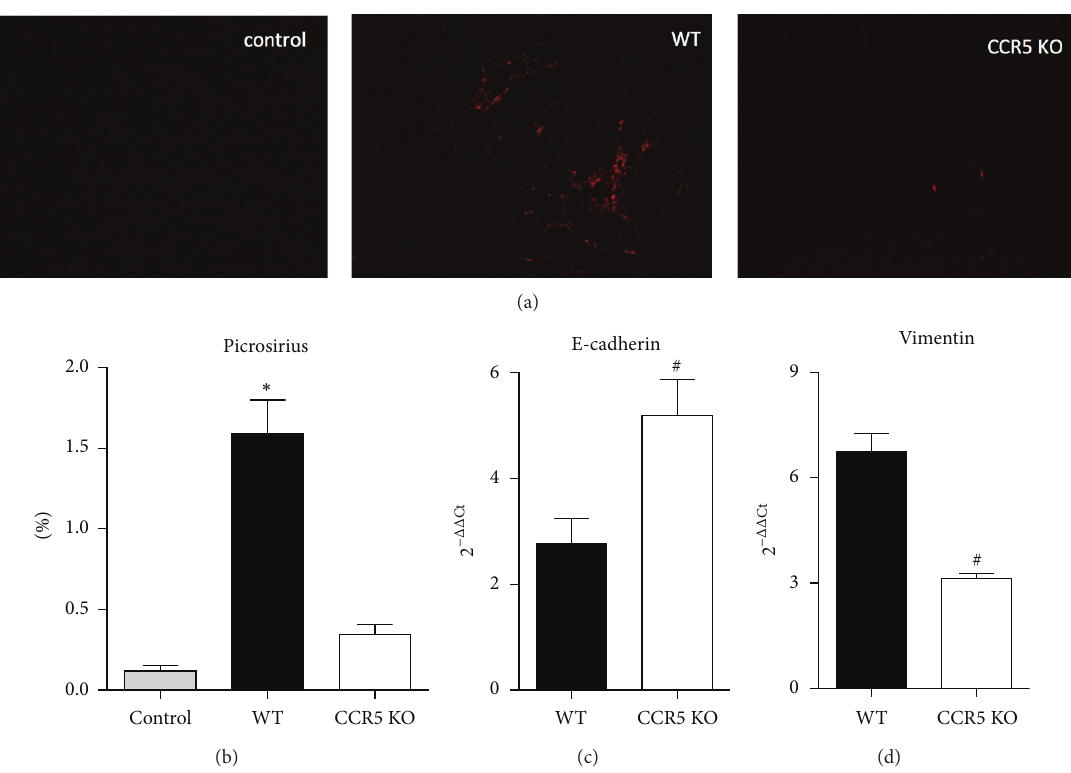
Figure 6: CCR5 deficient animals show less fibrosis after adenine-enriched food intake. (a) Representative image of the picrosirius staining in renal tissue of the indicated groups. (b) Graphic quantification of the picrosirius positive area of each group ( 𝑃 < 0.01 versus control and CCR5 groups). The gene levels of E-cadherin (panel (c)) and vimentin (panel (d)) were also assessed ( # 𝑃 < 0.05 versus